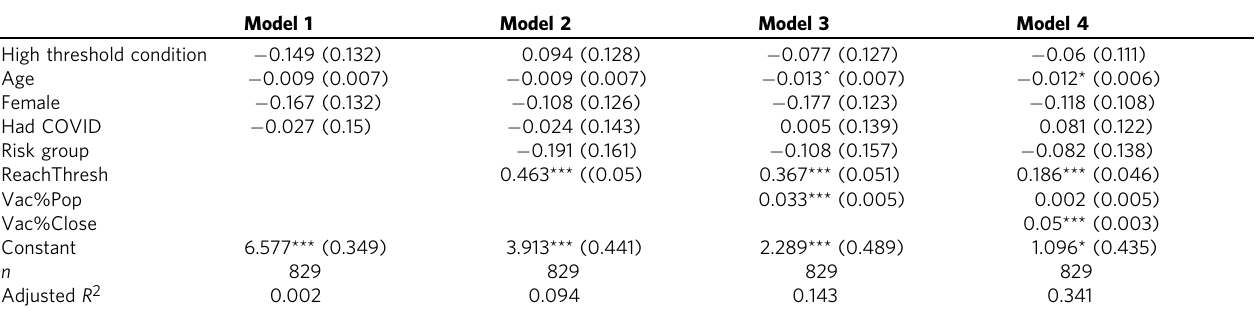
Table 2 OLS regression on vaccine willingness.